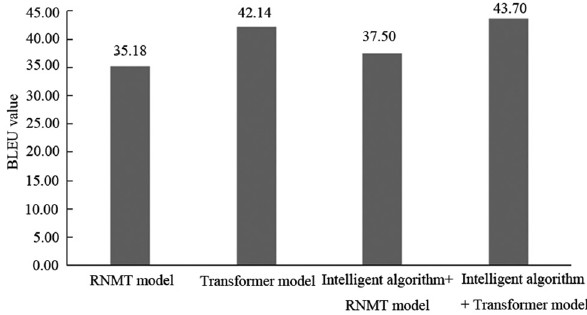
Figure 1: Comparison results of average BLEU values between di ff erent